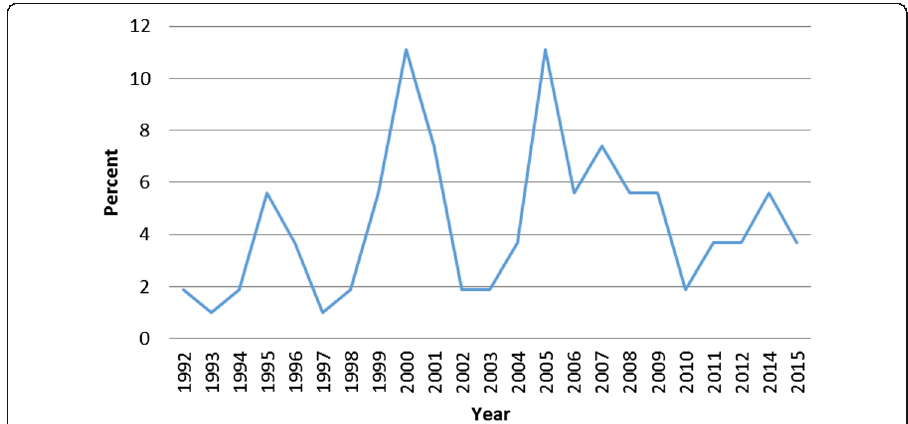
Fig. 1 First year of Web usage by